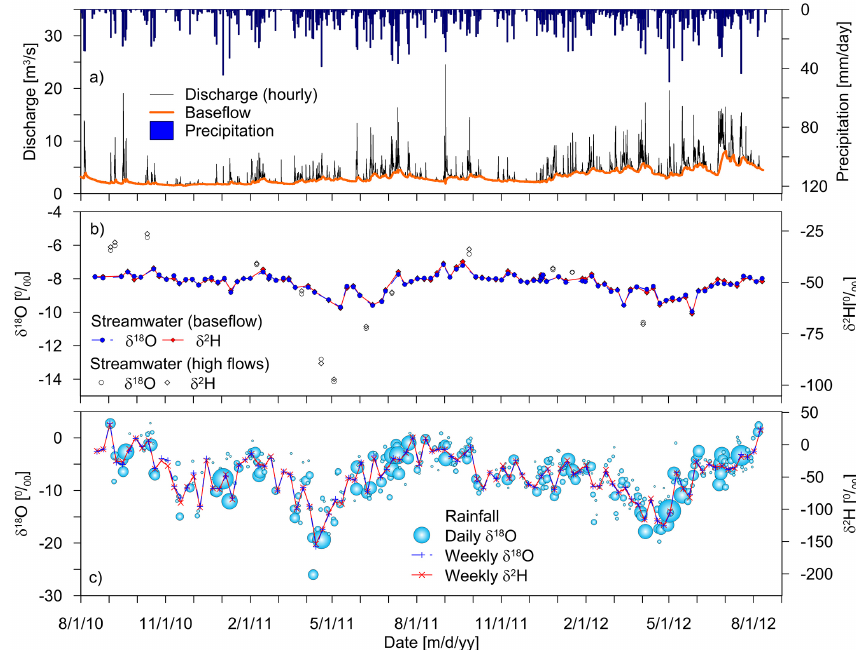
Fig. 2. (a) Time series of rainfall for ECSF meteorological station, hourly discharge and baseflows at the catchment outlet (PL); (b) weekly δ 18 O and δ 2 H of stream water at PL for baseflow and high flow conditions; and (c) weekly δ 18 O and δ 2 H at the ECSF rainfall sampling collector; light blue bubbles indicate daily δ 18 O and relative volume of daily